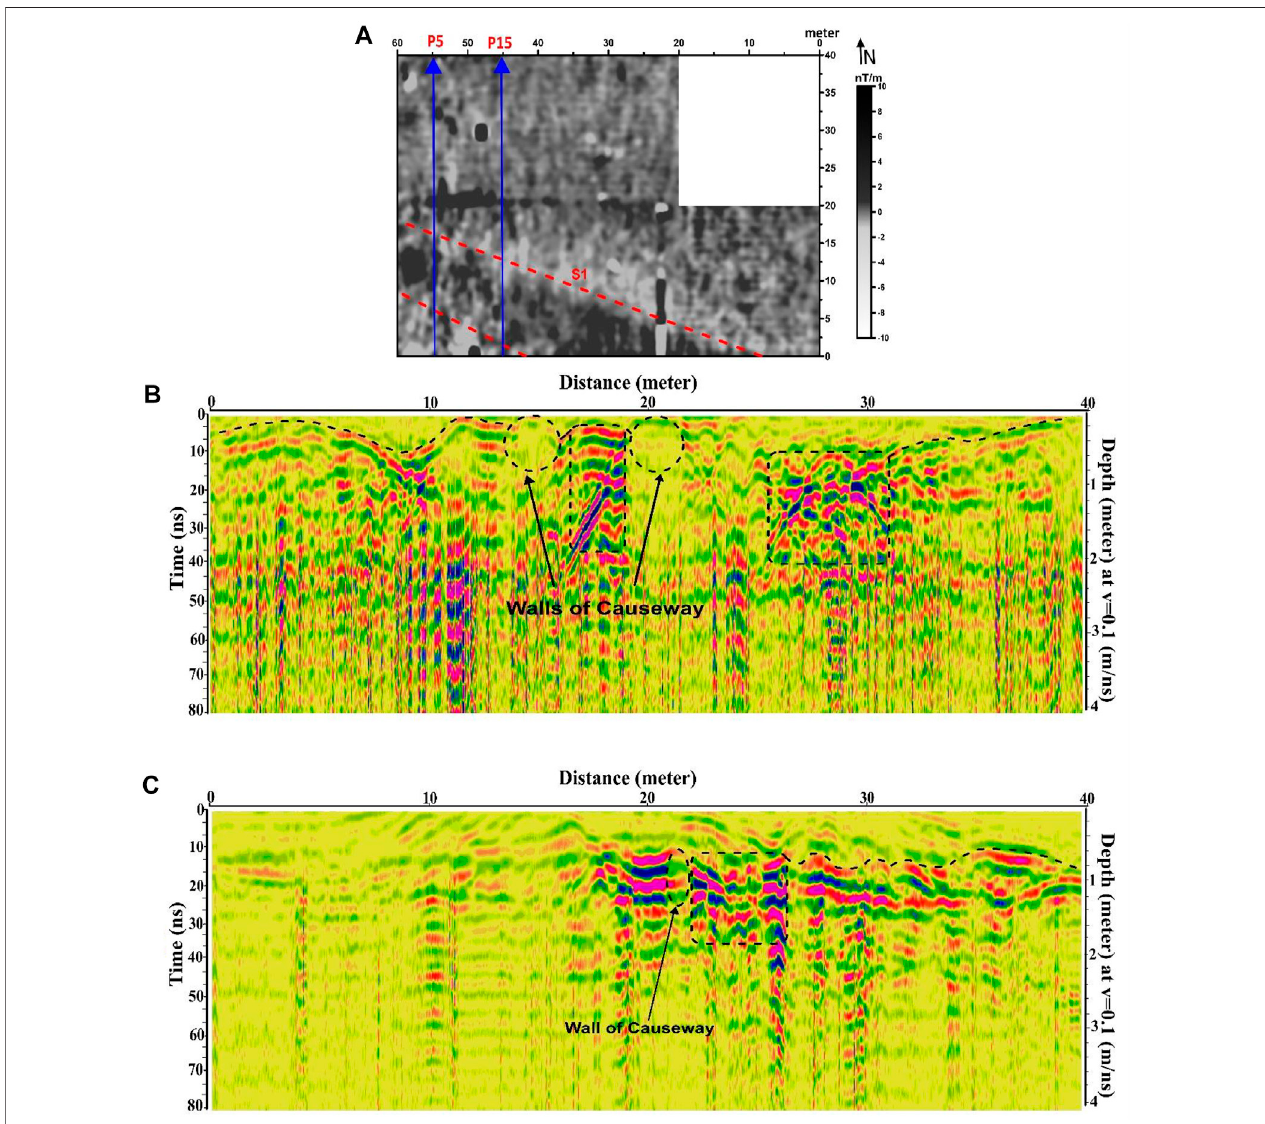
FIGURE 5 | (A) The location of the GPR pro fi les P5 and P15 at site B. (B) GPR display of radar pro fi le P5. (C) GPR display of radar pro fi le P15.